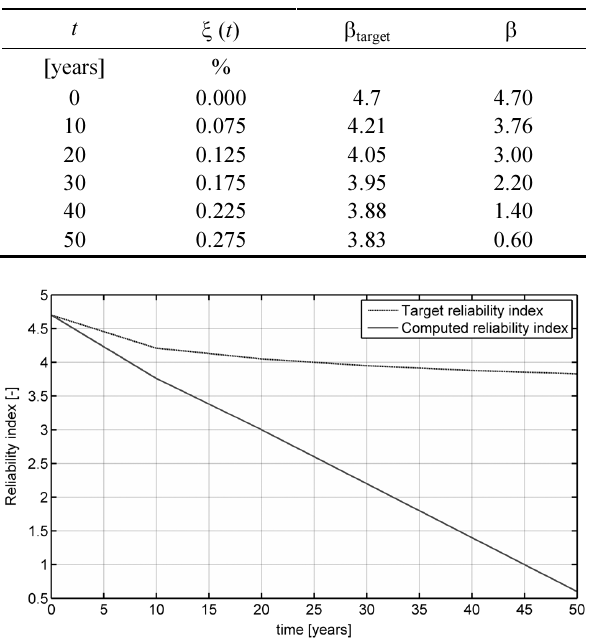
Fig. 10. The reliability indexes plotted versus time. A compari- son between the target reliability index (dashed line) and calcu- lated reliability index (solid